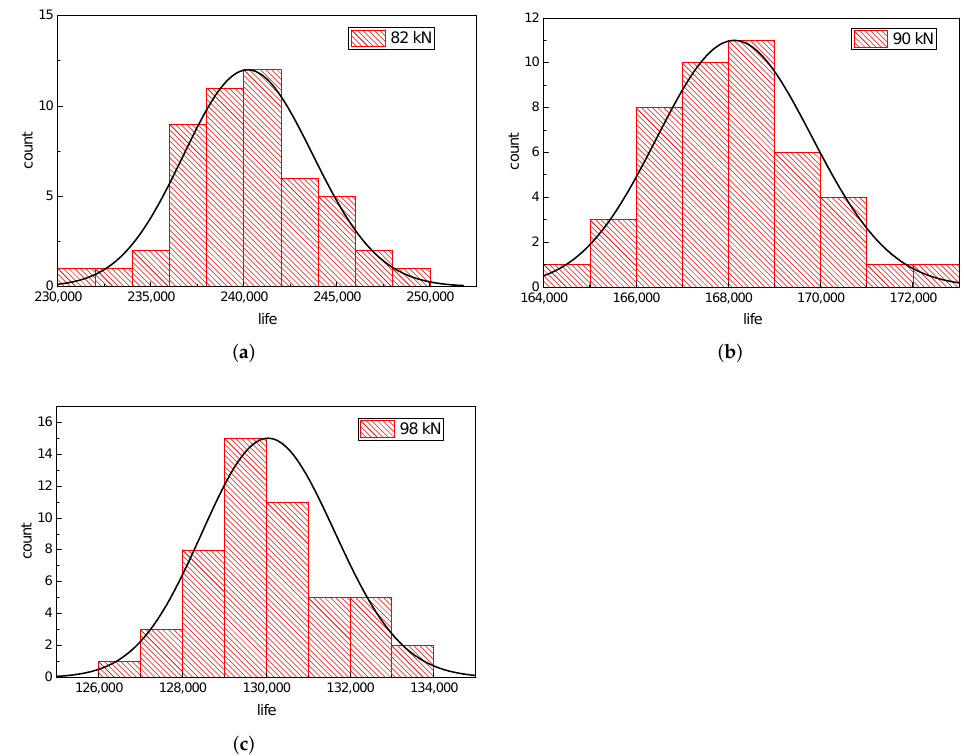
Figure 17. ( a ) Life distribution of P max = 82 kN. ( b ) Life distribution of P max = 90 kN. ( c ) Life distribution of P max = 98 kN.